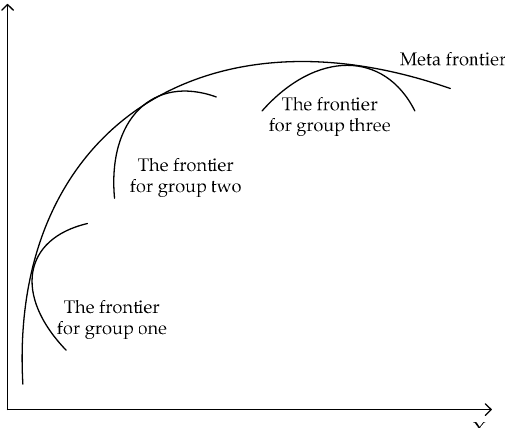
Figure 1. Meta-frontier and group frontier technologies.